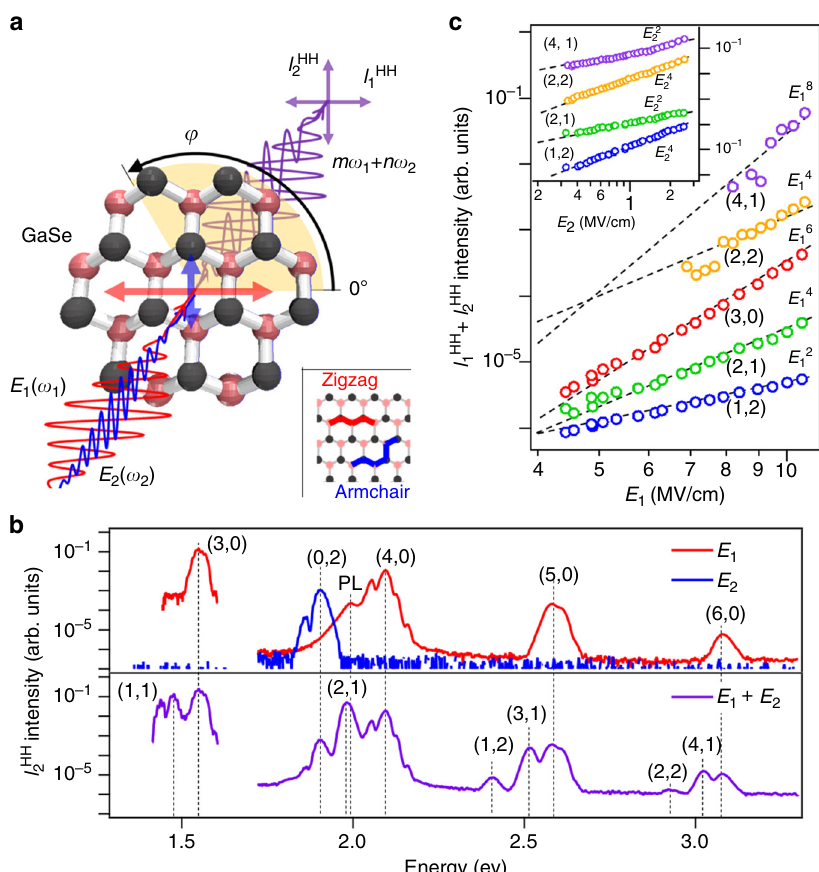
μ m). The generated HHs (observed at the energies m ħ ω + n ħ ω 1 2 ) and I HH , are measured as a 1 2 component in the HH spectra separately obtained by 2